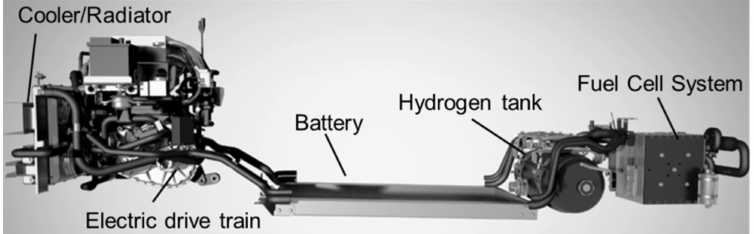
Figure 6. Typical fuel cell range extended electric vehicle: Multiple systems are combined to form a hybrid technology solution